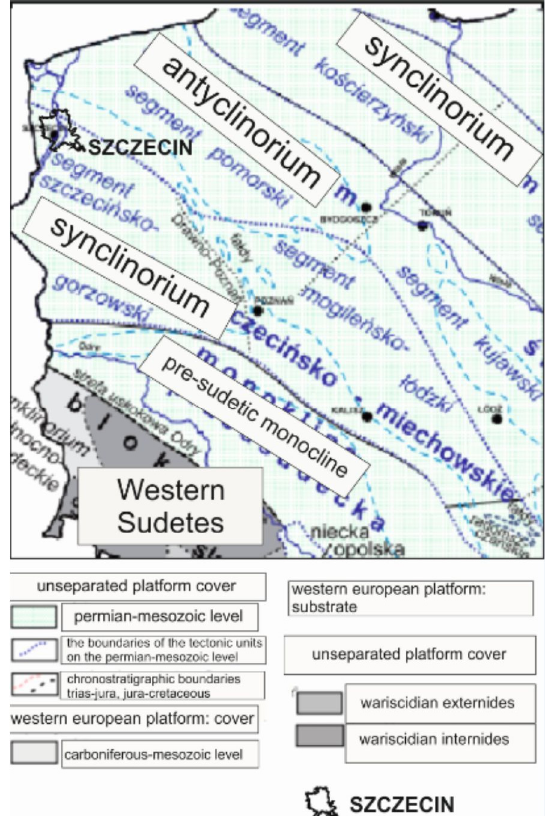
Figure 4. Location of the study area against a background of the main tectonic units of North-Western Poland (based on [7]).